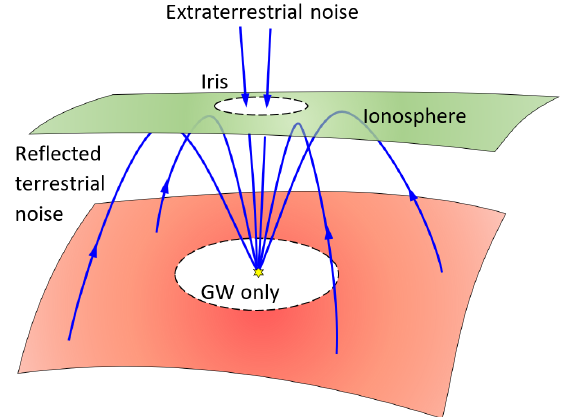
Figure 2. Terrestrial artificial noise is reflected by the ionosphere. Extraterrestrial noise is received through the ionospheric ‘iris’, a circular area in the ionosphere that is transparent for electromagnetic waves. The iris can be hundreds of kilometers wide, depending on the observation frequency and the peak plasma frequency of the ionosphere. The iris is fully closed when the observation frequency is smaller than the peak plasma frequency. Local noise can only be received via groundwave (GW).